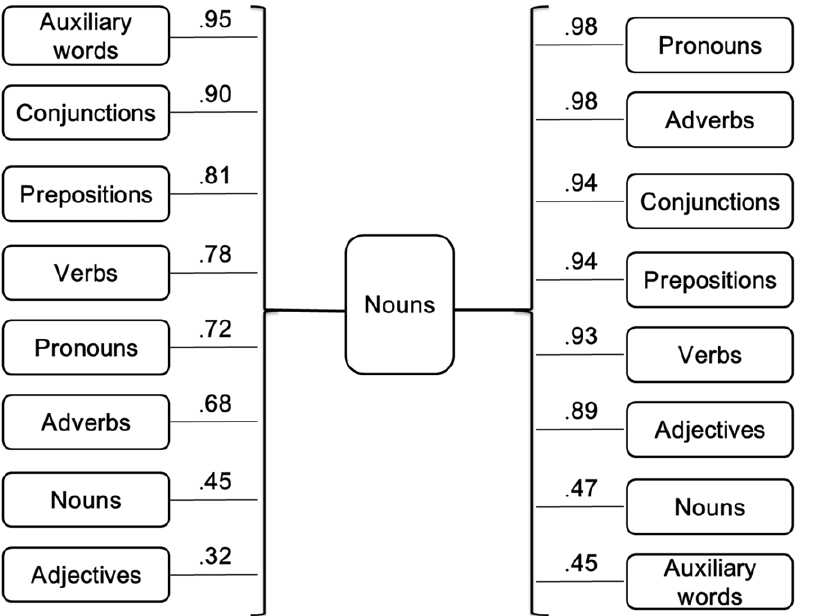
Figure 11. Nouns and adjacent words. Average agreement proportions for word boundaries between the nouns and different adjacent syntactic categories of SWU. The left values of the figure show the average agreement proportion between the preceding words and the nouns, and the right values of the figure show the average agreement proportion between the nouns and the subsequent words.